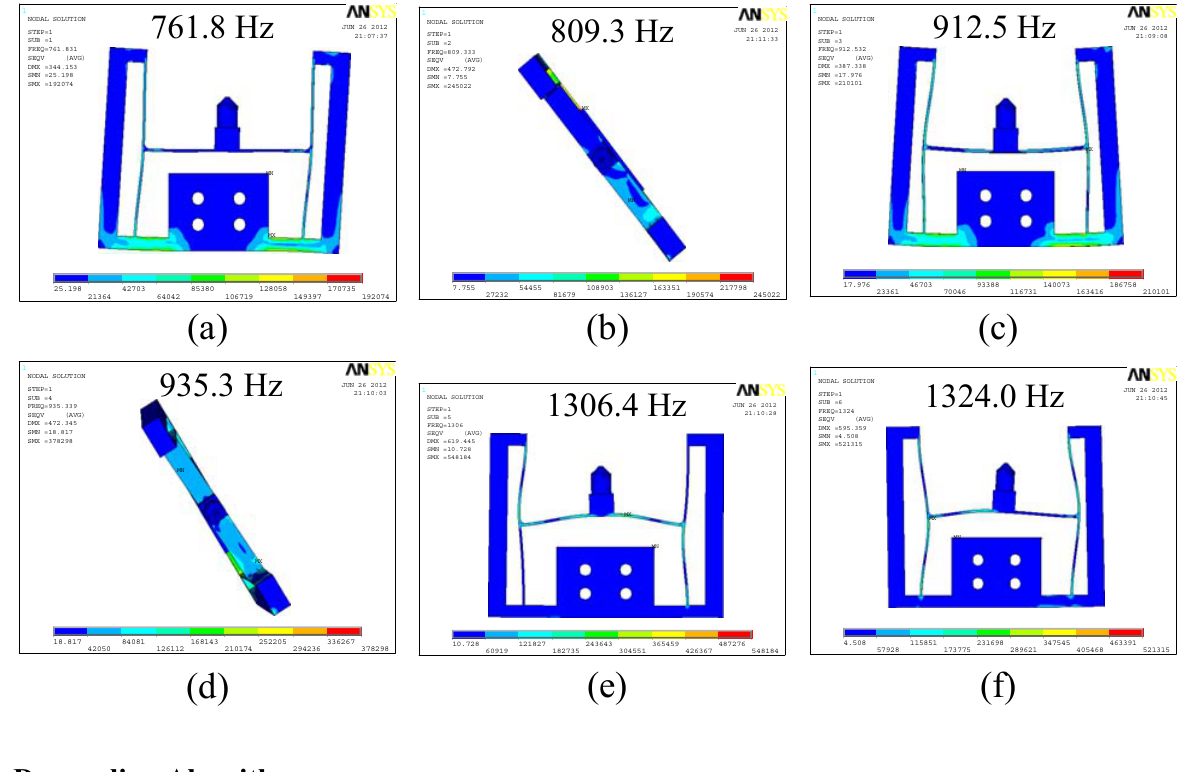
Figure 5. The first six order mode shapes of the elastic body including the